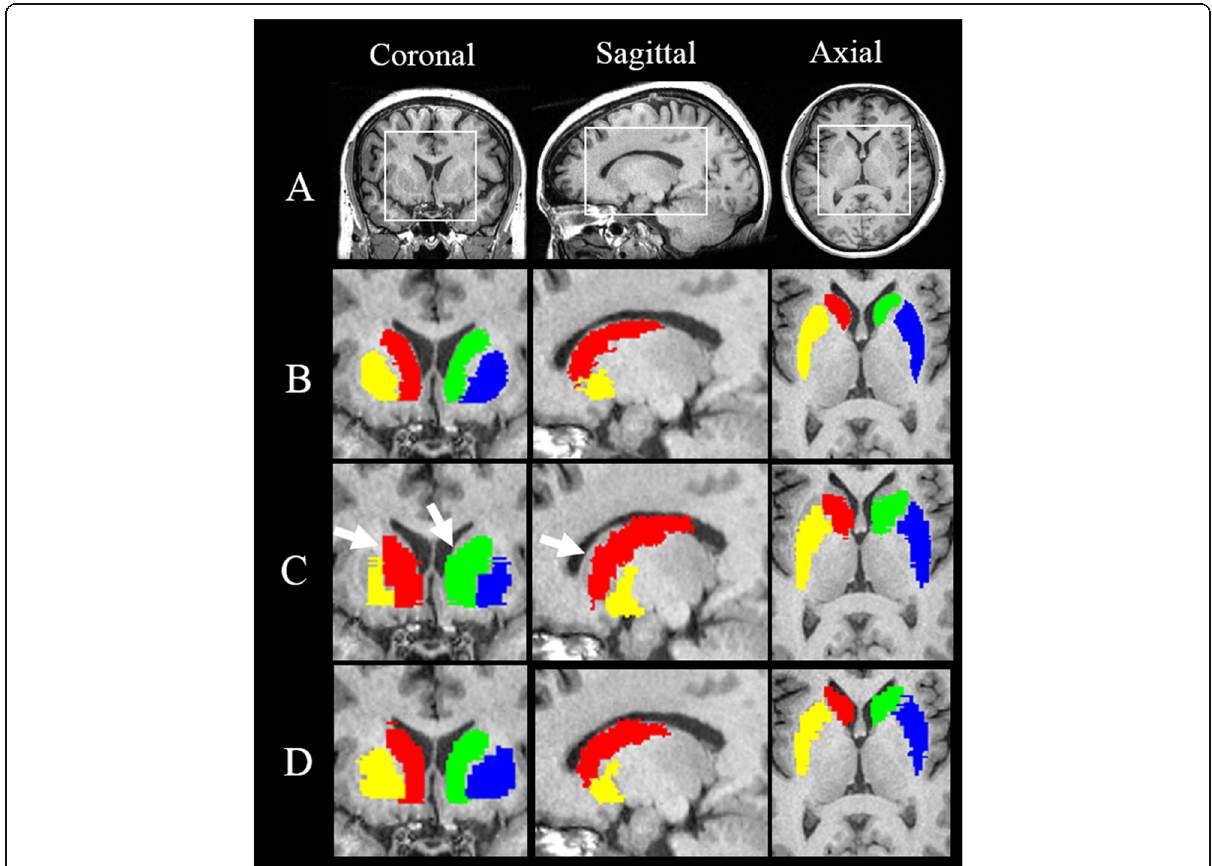
Fig. 4 Representative visualization of segmented brain nuclei including caudate nucleus (green: CAU_L, red: CAU_R) and putamen (blue: PUT_L, yellow: PUT_R) by using manual segmentation ( b ), RSIAT method ( c ), and RATSI ( d ). The areas in the white box in T 1 images ( a ) were the regions shown below. And the segmented regions of interest (ROIs) for nuclei were overlapped on T 1 images in coronal (left), sagittal (middle), and axial views (right), respectively, for better